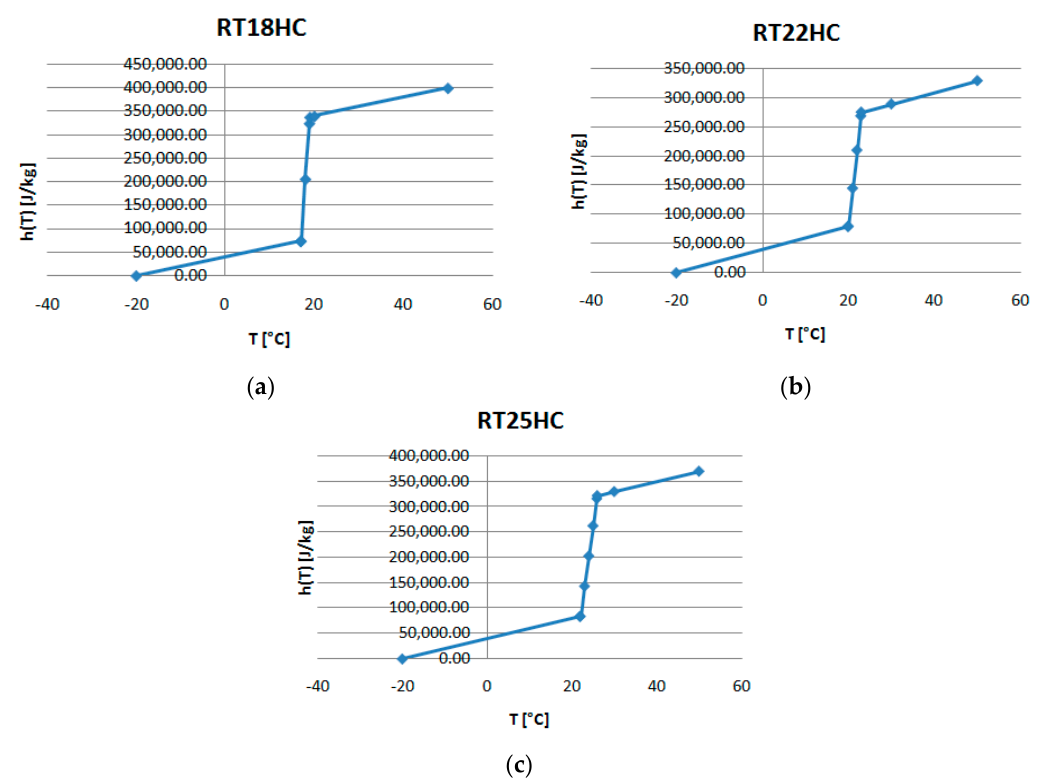
Figure 5a–c present the temperature–enthalpy functions corresponding to the studied PCMs.